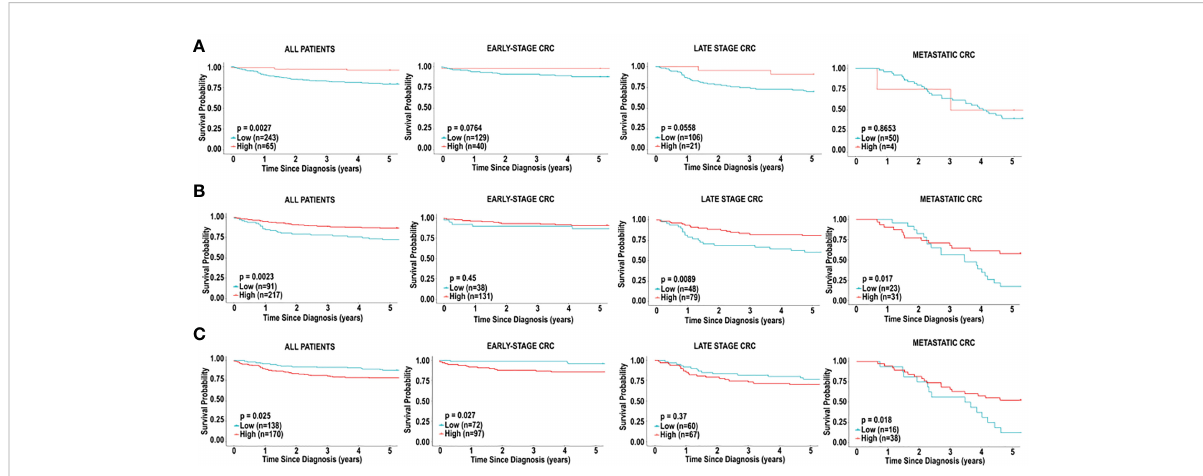
FIGURE 4 Immune cell in fi ltration and survival analysis of CRC based on activated dendritic cells. (A) Kaplan-Meier curve for overall fi ve-year survival based on relative cell fractions of activated dendritic cells, based on CIBERSORT analysis for all patients, patients with early-stage CRC, late-stage CRC and metastatic CRC. (B) Kaplan-Meier curve for overall fi ve-year survival based on relative cell fractions of activated dendritic cells, based on MCP-counter analysis for all patients, patients with early-stage CRC, late-stage CRC and metastatic CRC. (C) Kaplan-Meier curve for overall fi ve-year survival based on relative cell fractions of activated dendritic cells, based on xCell analysis for all patients, patients with early-stage CRC, late-stage CRC and metastatic CRC. Groups with high and low cell numbers were compared with log-rank